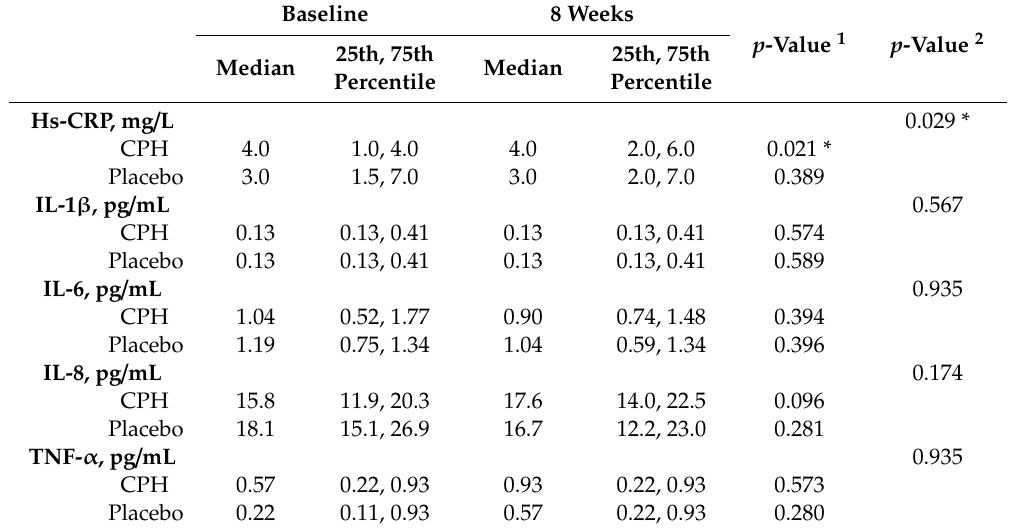
Table 2. The concentration of inflammatory markers in serum samples collected before and after 8 weeks supplementation with cod protein hydrolysate (CPH) ( n = 15) or placebo ( n =